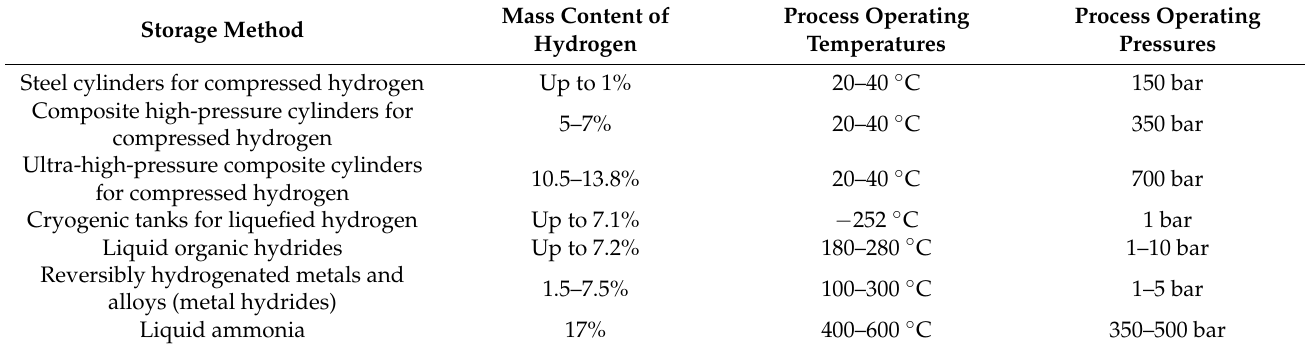
Table 1. Technological characteristics of hydrogen storage methods. Data from